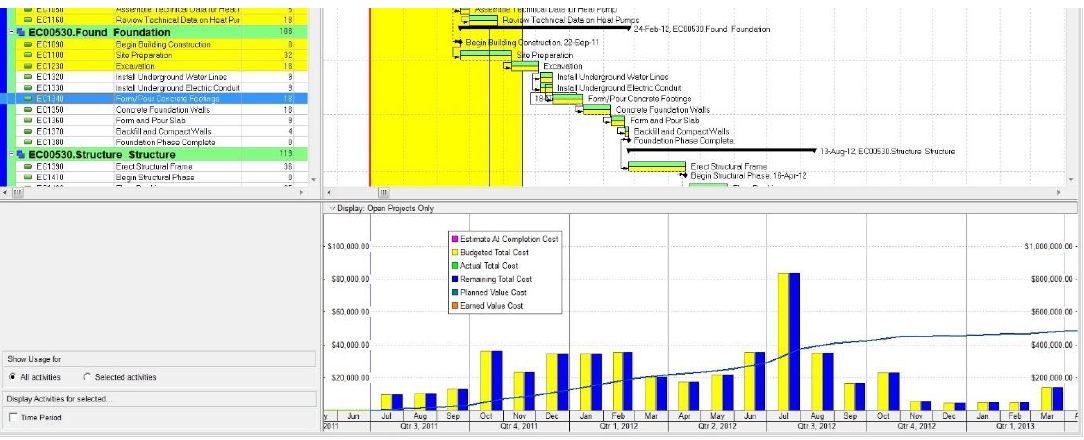
Figure 11. Primavera P6 Progress Spotlight. 7. Project Schedule Delay Analysis from Project Management Methodology Perspectives